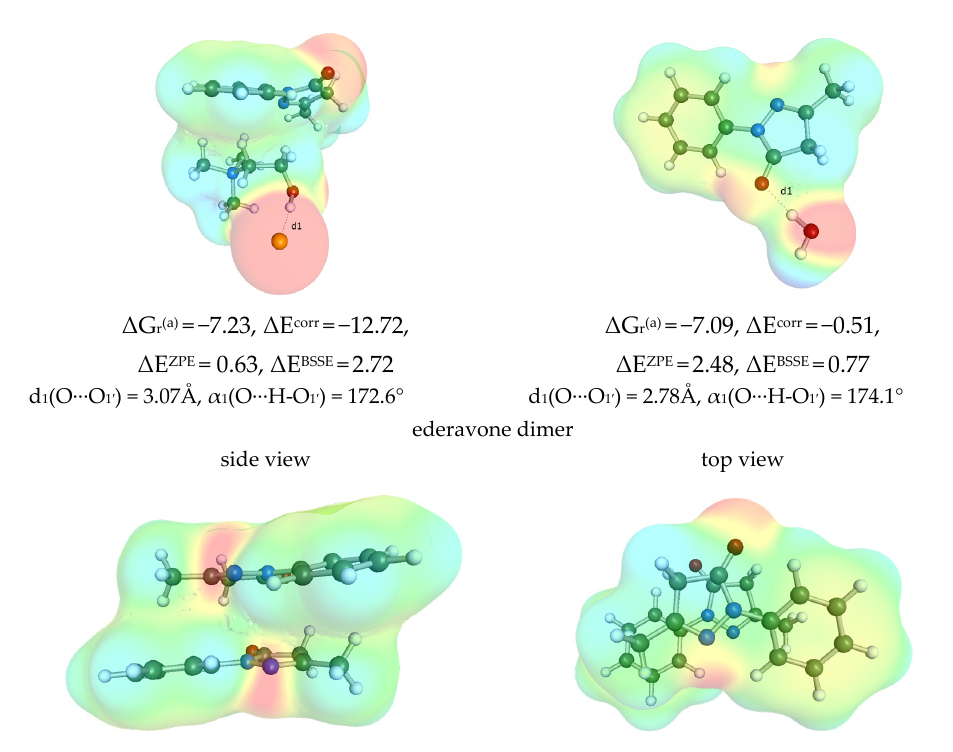
Figure 9. The most representative geometric and energetic properties of edaravone complexes with DES constituents. All thermodynamic contributions expressed in kcal/mol represent relative values for X + Y = XY reactions. Notation is the same as in Figure 7.